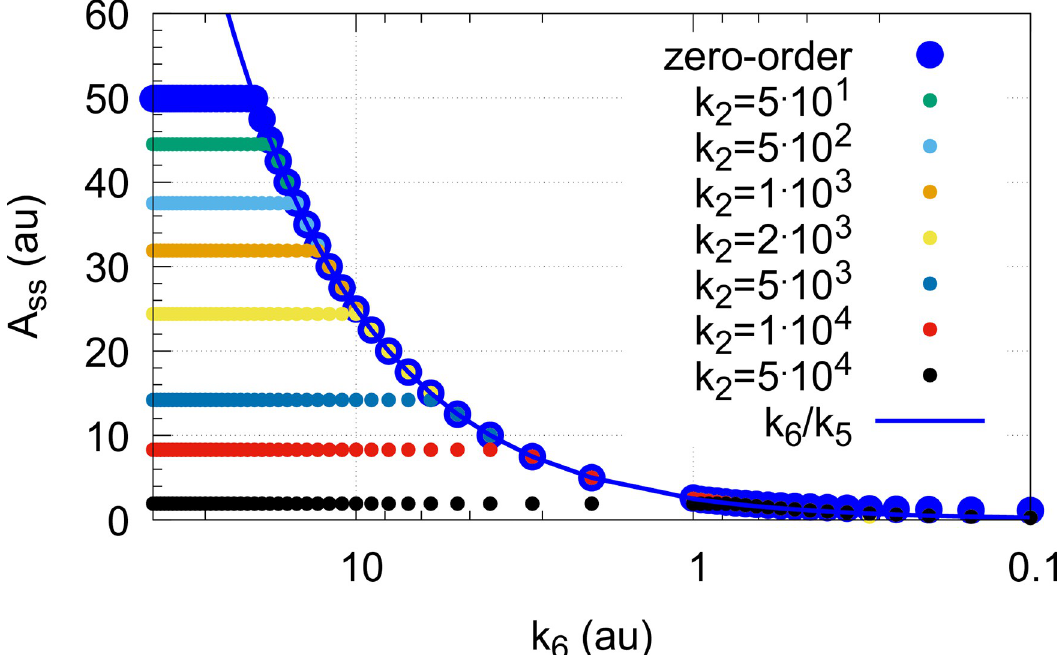
Fig 18. Influence of step-wise k 2 for catalyzed m2 controller under nonzero-order conditions. The mechanism considered in that of Fig 15b. Small colored dots indicate A ss levels for different k 2 values when k 9 = k 11 = k 13 =1 × 10 7 and Ez tot =2.0 × 10 − 5 . For comparison, large blue dots show the A ss values under zero-order conditions when k 9 = k 11 = k 13 =1 × 10 9 and k 2 =1.0. Other rate constant values and initial concentrations are as in Fig 17.